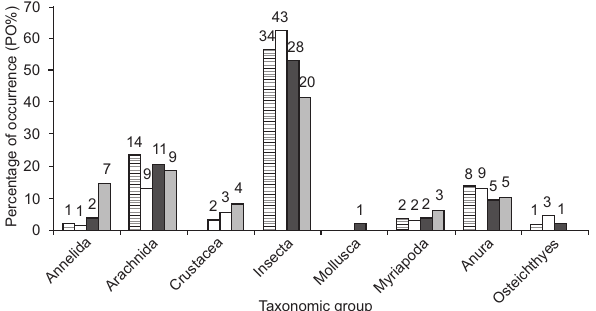
Figure 1. Percentage of occurrence and number of items (above the bars) of each taxonomic group between the seasons, present in the diet of adult Lithobates catesbeianus . Winter (black with white), spring (white), summer (black), and fall